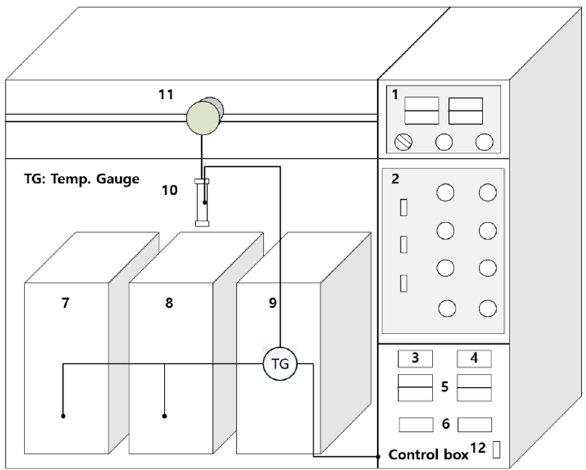
Figure 1. Schematic diagram of the bomb-tubular reactor system: (1) timer and counter; (2) control box; (3) voltmeter; (4) ammeter; (5) thermo-controller; (6) temperature indicator; (7) molten salt bath; (8) silicon oil bath; (9) cooling bath; (10) batch reactor; (11) electric motor; (12) main switch.